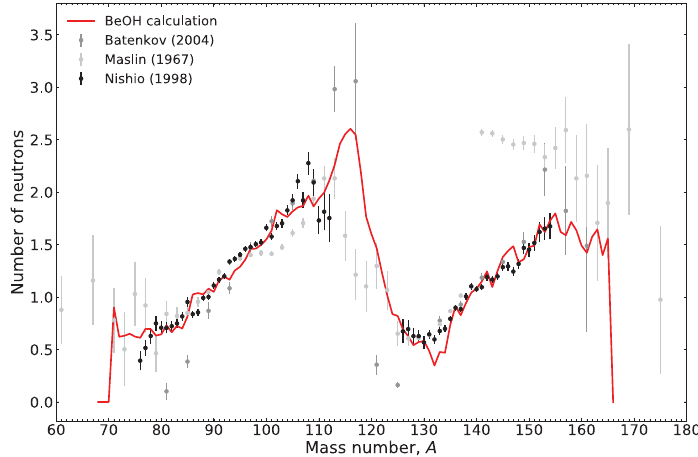
Figure 4. The calculated average number of prompt fission neutrons emitted (red) versus fragment mass number as compared to data (black and gray points) for the thermal neutron induced fission of 235 U. This calculation corresponds to the independent fission yield (blue line) in Fig.